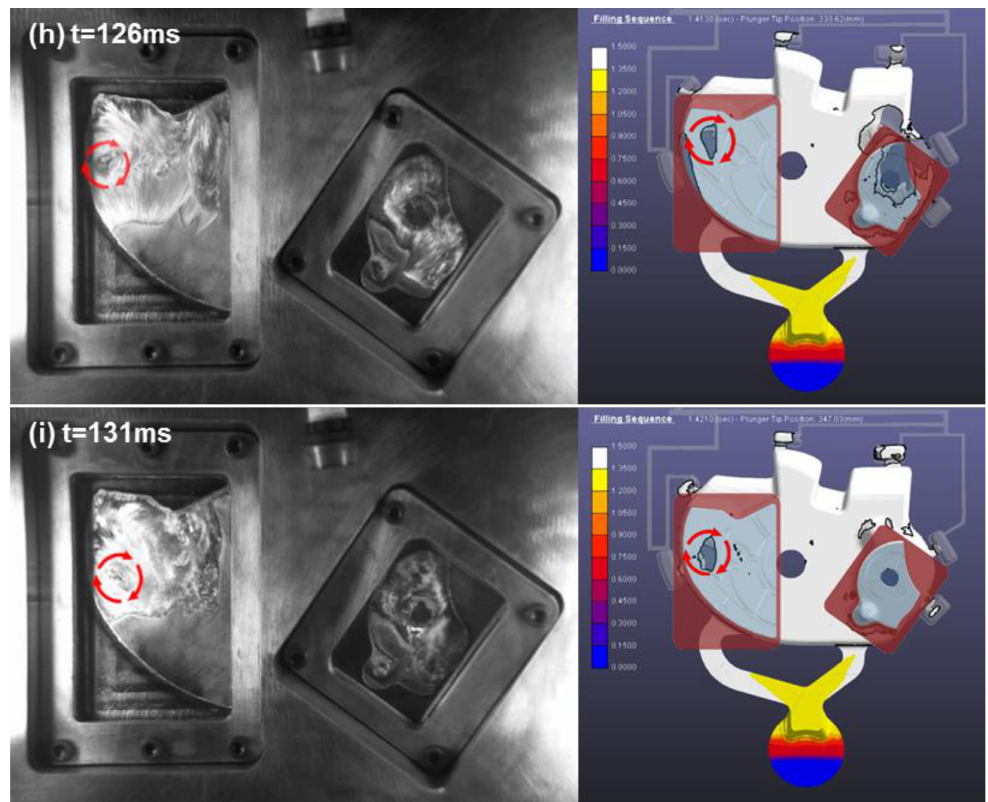
Figure 3. The comparison between the numerical simulation (right) results and the flow visualization experiment (left) within the transparent windows (the time shown in ( a – i ) is the actual experimental time from when the fluid has just started entering the right window).